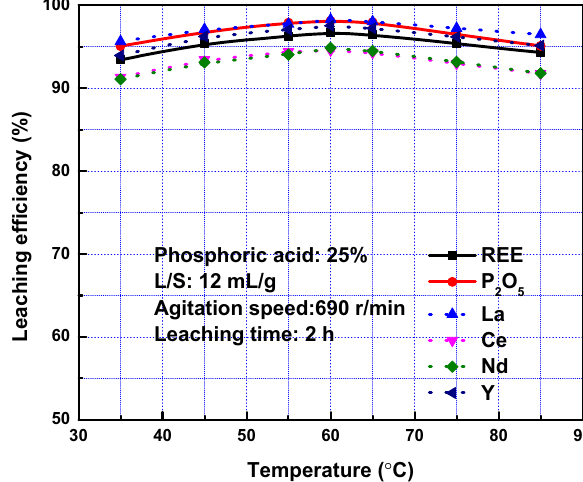
Figure 3: Leaching e ffi ciencies of REE and P 2 O 5 as a function of phosphoric acid concentration in initial leaching pulp.